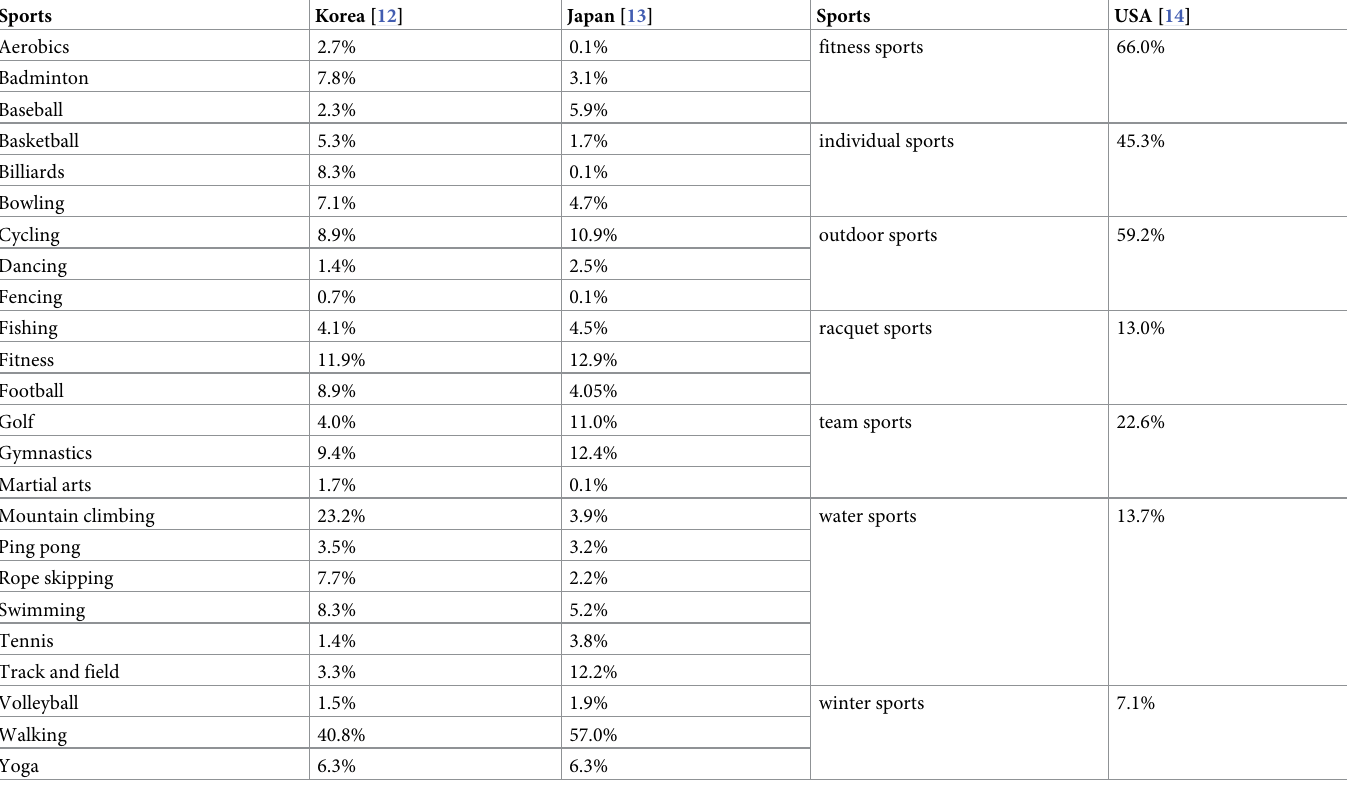
Table 1. Popularity of community sports in Korea, Japan, and the